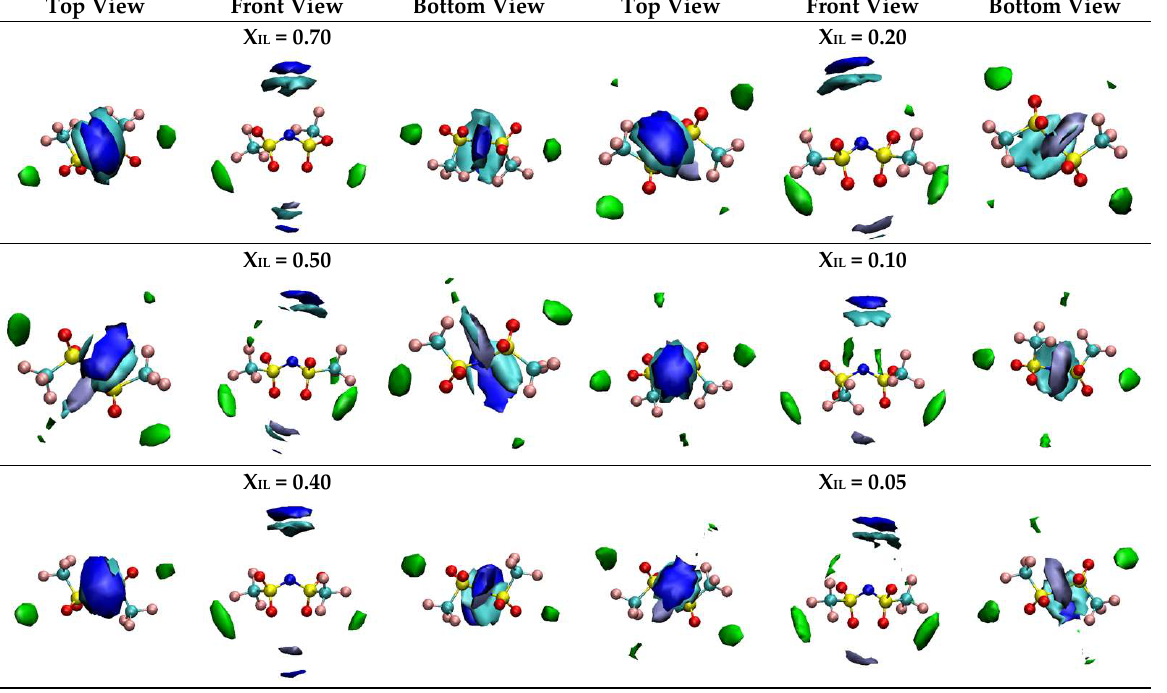
Figure 16. Selected spatial distribution functions around the [NTf 2 ] − anion in aqueous mixtures of [N 1 2OH 2OH 2OH ][NTf 2 ] at 300 K. The blue and cyan colors represent cation N atom and CH 3 group, respectively, green denotes F atoms of anion and light blue depicts water O atom. The isosurface value is 70% of the maximum number density.